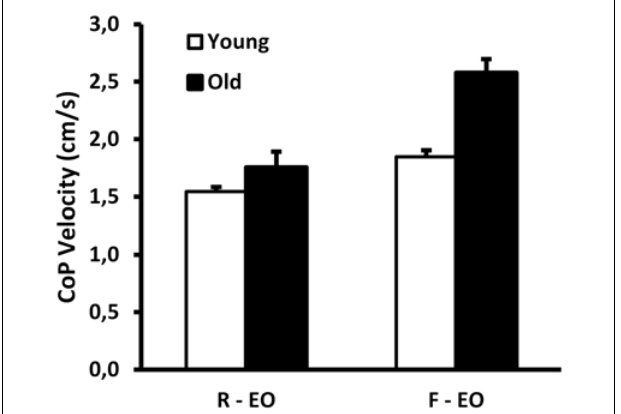
FIGURE 1 | Group data (mean ± SE) for young and old adults of center of pressure velocity when standing on a rigid (R) surface and on foam (F), showing a significant interaction effect ( p = 0.001) EO: eyes